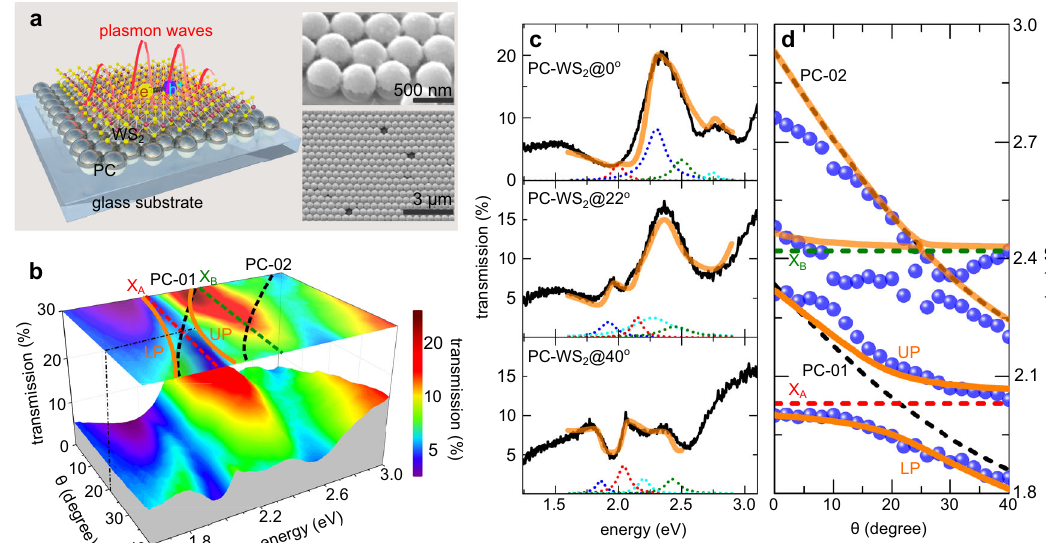
Fig. 1 Structures of a PC-WS 2 sample and steady-state optical properties. a schematic of polariton formation in a WS 2 ML that is supported on a self- assembled plasmonic crystal (PC), where excitons consisting of electrons (e − ) and holes (h + ) are coupled to plasmon waves. The Al 2 O 3 spacer is not depicted for similicity. right insets: side and top-view scanning electron microscope images; b angle-resolved transmission spectra under p-polarised illumination and their projection (top x – y plane), in which the spectral positions of exciton A ( X A , red dashed line) and B ( X B , green dashed line), calculated dispersions of plasmon lattice modes (black dashed curves), and upper and lower branches of polaritons (orange curves) are indicated. The tuned angle ( θ = 22°) is marked with a black dash-dotted line. c The p-polarised transmission spectra (black curves) of a PC-WS θ = 0, 22, 40°; 2 sample measured at thick orange curves indicate the fi tted results using supplementary Eq. S1, and thin dotted curves represent the fi tting components, whose amplitudes have been adjusted for visualation. d spectral positions of the fi tted resonances (solid blue circles) in the PC-WS 2 sample at different illumination angles; the red (green) dashed line indicates the spectral position of exciton A (B); the black dashed curves indicate the simulated dispersions of plasmon resonances, while orange solid curves indicate the fi tted dispersions using supplementary Eq.